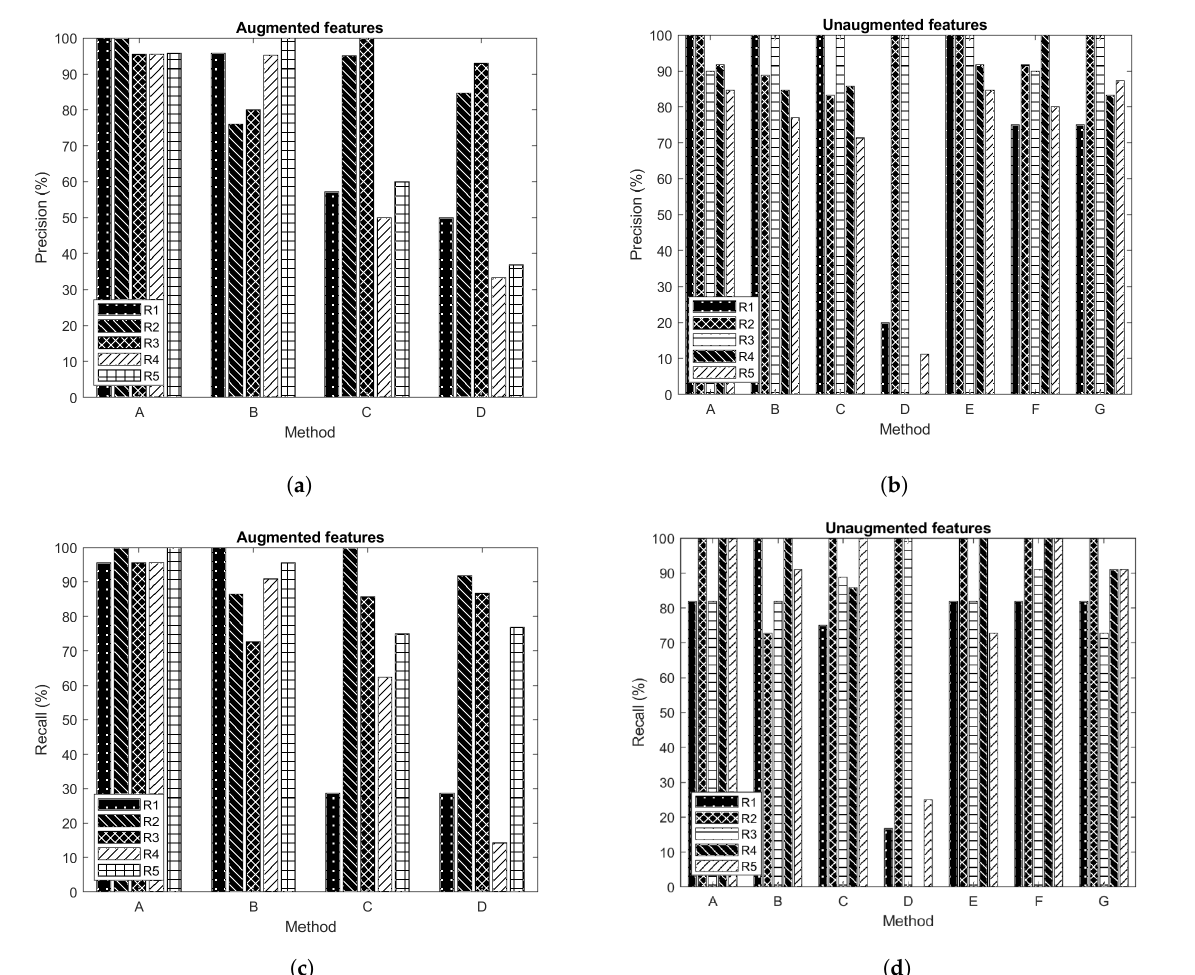
Figure 7. Room identification precision ( a , b ) and recall ( c , d ) results for augmented and unaugmented features